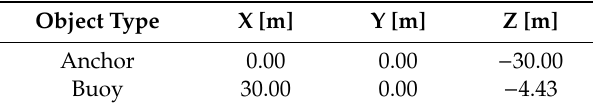
Table 6. The initial position of the